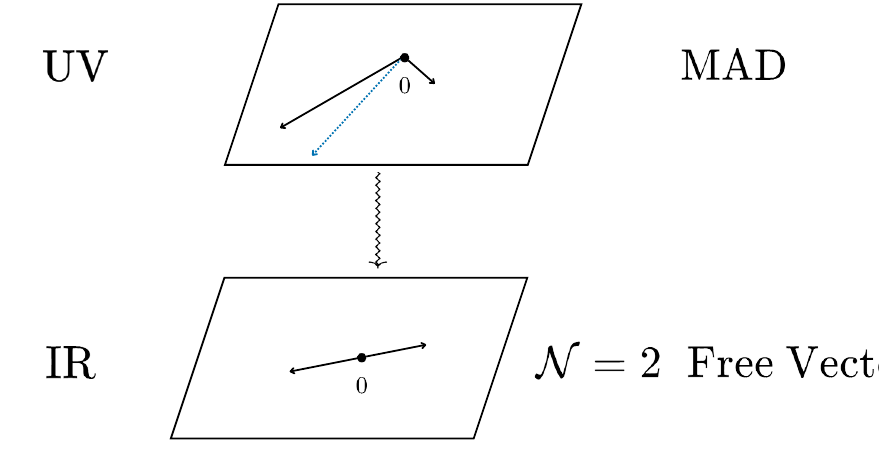
Figure 2 . Each complex plane contains index contributions (for some generic choice of complex fugacitites) from multiplets in the UV and IR respectively. Each multiplet contribution can be represented as a vector in C . In the IR plane, we show cancelling index contributions for a pair of operators satisfying (3.23) for fixed n and different parity of p . In the UV plane, we show the contributions from the two UV avatars of these operators, where their index contributions no longer cancel (their sum is given by the blue vector) due to the constraint in